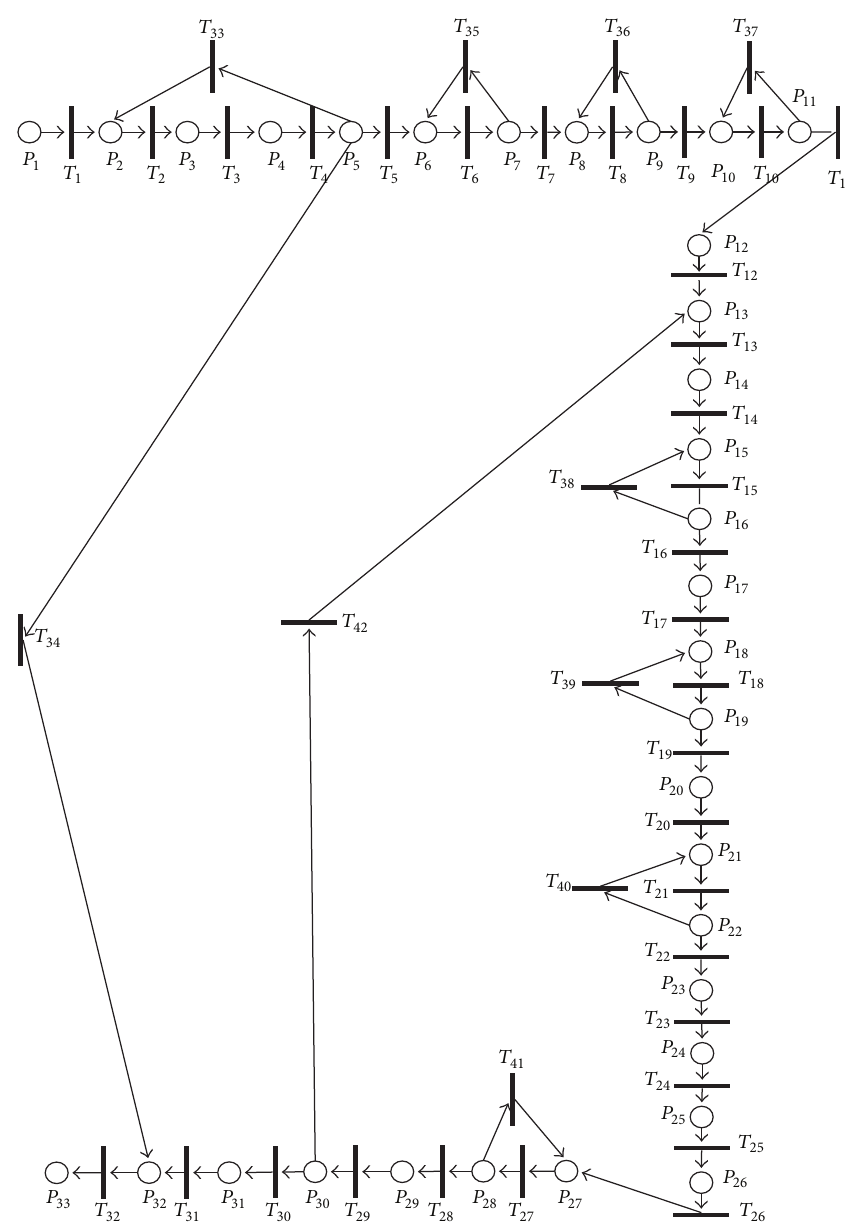
Figure 11: Petri net model chart of R&D production process